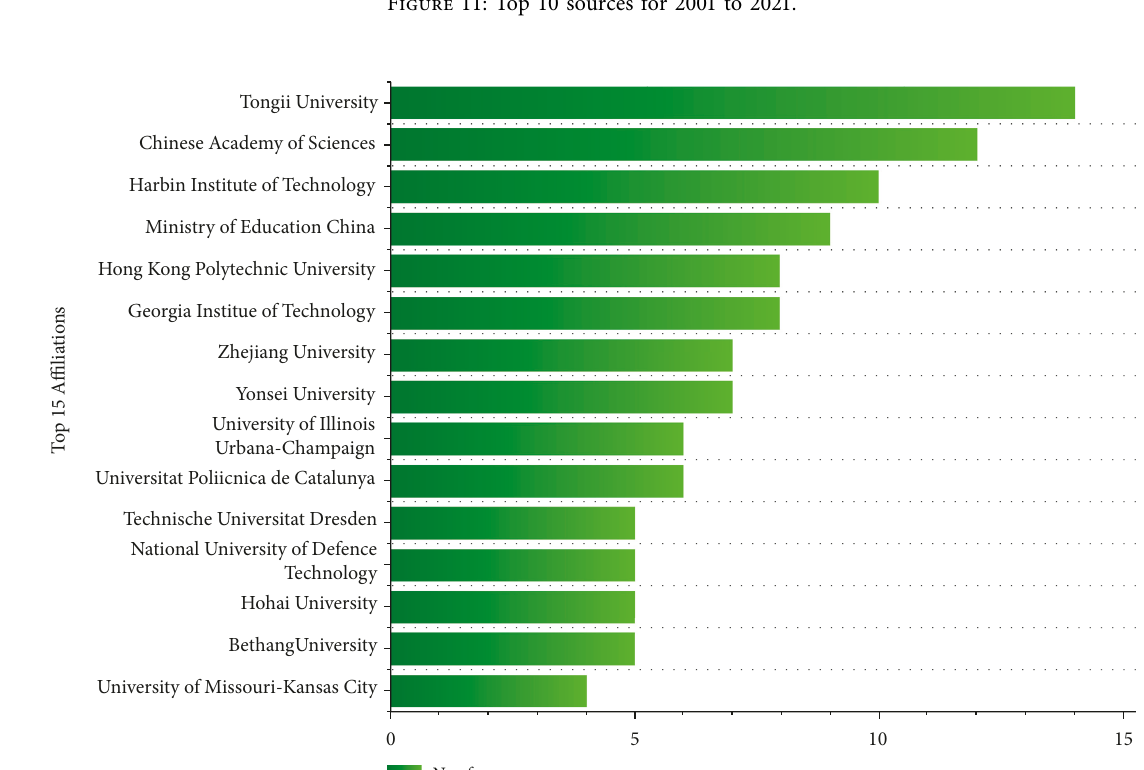
Figure 12: Top 15 affiliations for 2001 to 2021.